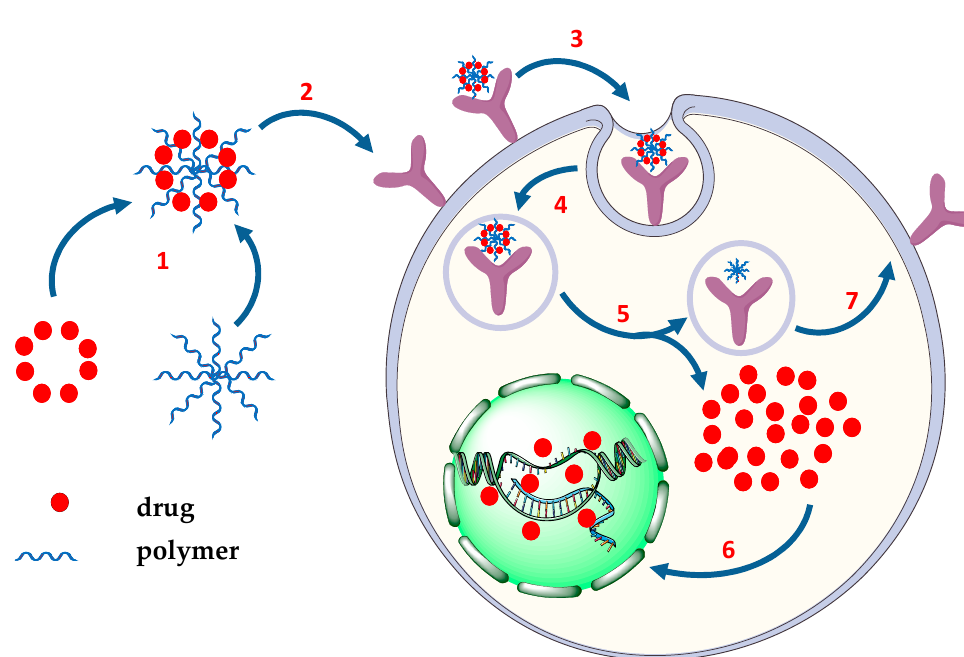
Figure 4. Mechanism of endocytosis of drug–polymer conjugates mediated by folate receptors. 1—drug–polymer conjugation; 2—FR binding; 3—membrane invagination; 4—endocytosis; 5—drug release; 6—DNA targeting; 7—FR externalization [69,70].